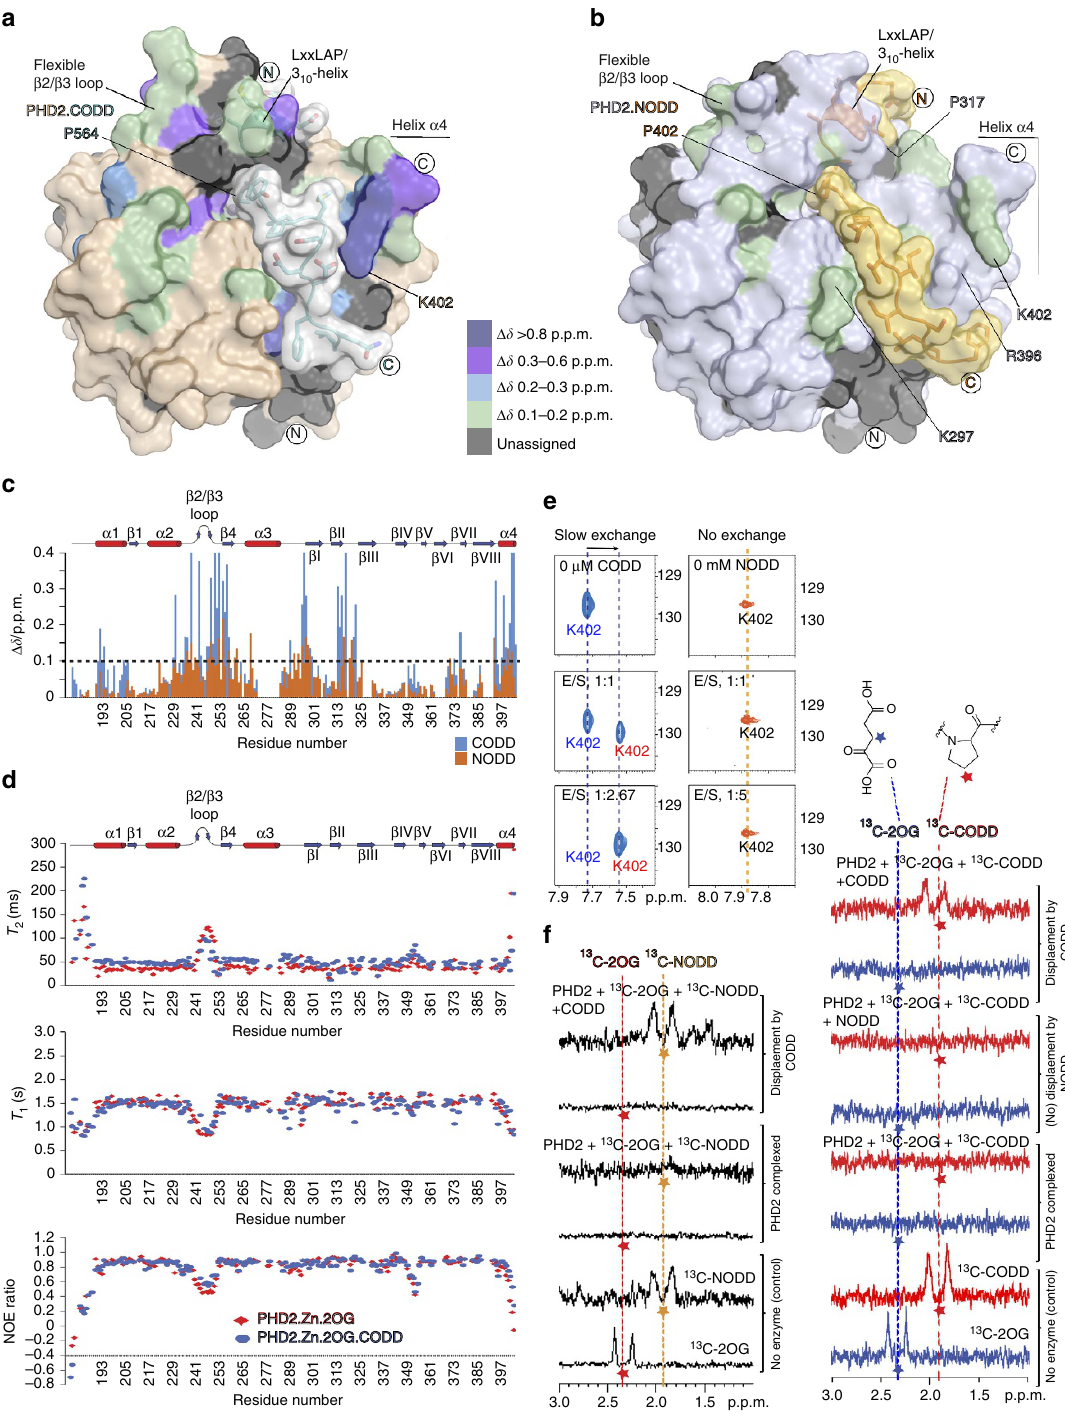
Figure 6 | NMR studies reveal dynamics of ODD selectivity determinants in solution. Surface representations of PHD2.CODD (CODD in grey, PDB: 5L9B) ( a ) and PHD2.NODD (NODD in yellow, PDB: 5L9V) ( b ) showing perturbed regions (colour coded) on ODD binding with differences in chemical shift values in c . On CODD binding, changes concentrate in: N terminus ( a 1, aa 190–195; a 2, 229–231; b 2/ b 3 loop, 234–254; b 4, 255–258; and a 3- b I, 294–298), the DSBH core ( b I, 299–300; b II, 312–317; and b II– b III, 319–322) and C-terminal regions including the b VIII- a 4 loop (391–393) and a 4 (395–402). Compared with CODD, binding of NODD induces fewer changes including in: b 2/ b 3 loop (236–241 and 247–255), b 4 (257–258), b 4- a 3 (259–262), a 3 (268), a 3- b I (290–299) b II– b III (318–319), and b VI– b VII (369–370), and smaller changes (relative to CODD) in a 4 (398–400). ( d ) 15 N relaxation ( T 1 / T 2 ) and 1 H- 15 N NOE measurements reveal b 2/ b 3 loop dynamics that are diminished on CODD binding. ( e ) 15 N HSQC experiments show that CODD binding directly perturbs PHD2 C terminus as exemplified by slow-exchange titration behaviour of Lys402 (291K), whereas binding of NODD has less/no influence (310K). ( f ) Competitive binding experiments (one-dimensional 13 C-selective clean in-phase (CLIP)–HSQC) reveal CODD binding displaces NODD but not vice versa within limits of detection. 13 C-2OG/ 13 C-NODD/ 13 C-CODD-selective excitations are indicated by coloured asterisks.